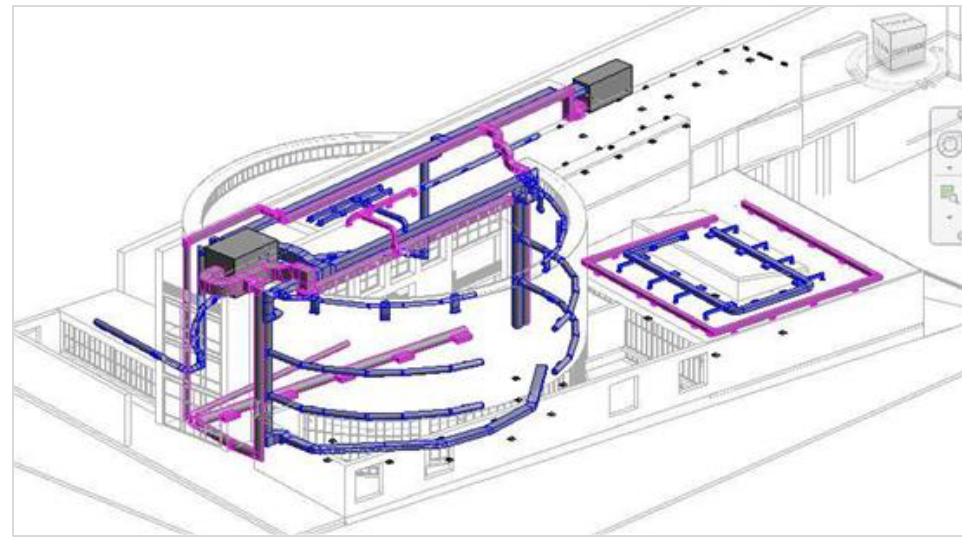
Figure 2. A 3D view of the air conditioning and lighting installations highlighted, through the application of view templates, with respect to the architectural and structural elements of the model.